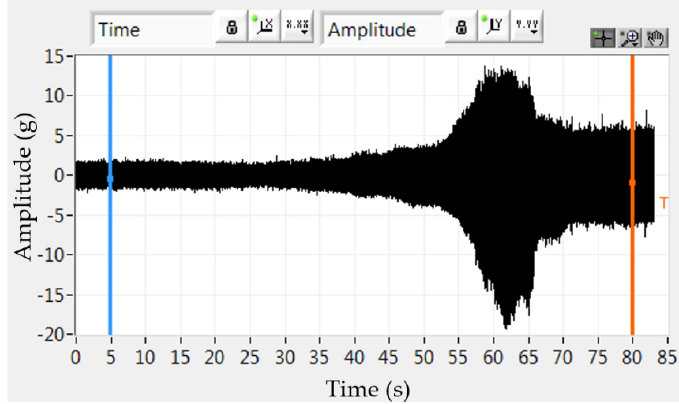
Figure 4. Time recording of acceleration amplitudes.